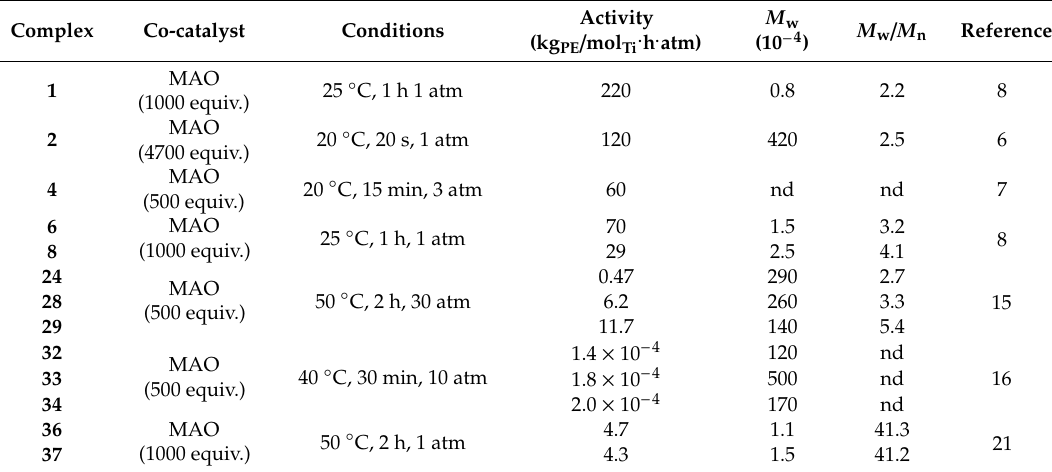
Table 24. Comparison between titanium catalysts for ethylene polymerization. Complex Co-catalyst Conditions